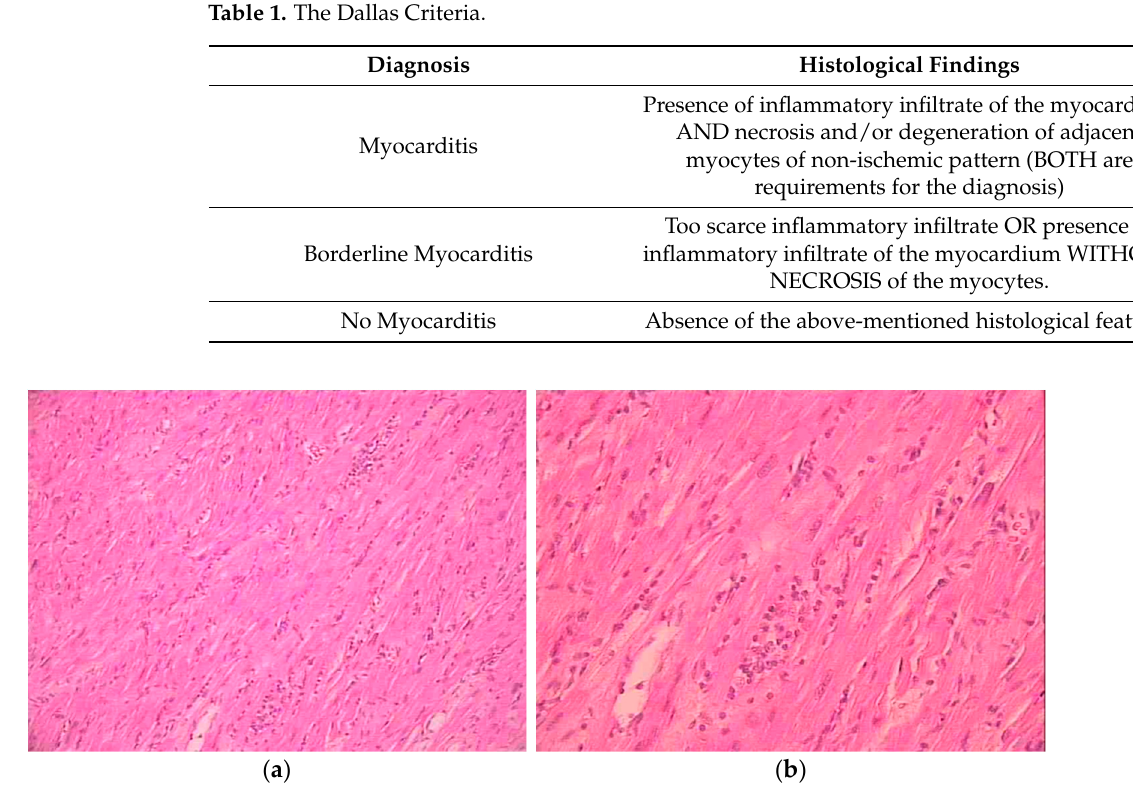
Figure 1. Myocardial histological sample showing lymphocytic infiltrate and myocyte necrosis. ( a ) ×10; ( b ) ×40. Table 1. The Dallas Criteria.